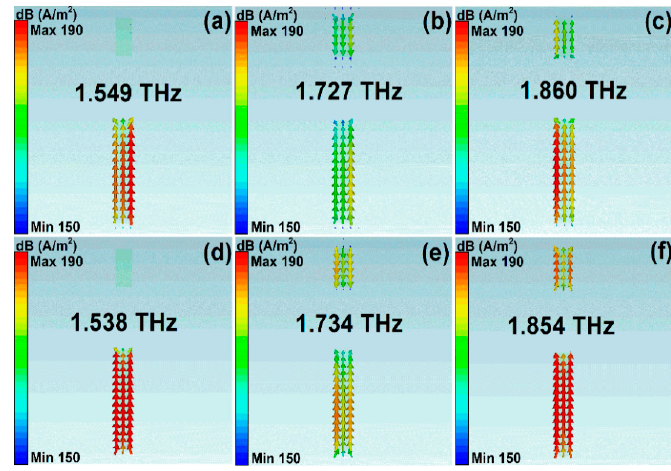
Figure 6. The magnetic fields for the asymmetrical graphene cut wire patters structures. ( a–c ) The simulation results for Model I. ( d–f ) The simulation results for the phonon scattering was taken into account. The polarization direction of incident light was along the y direction.